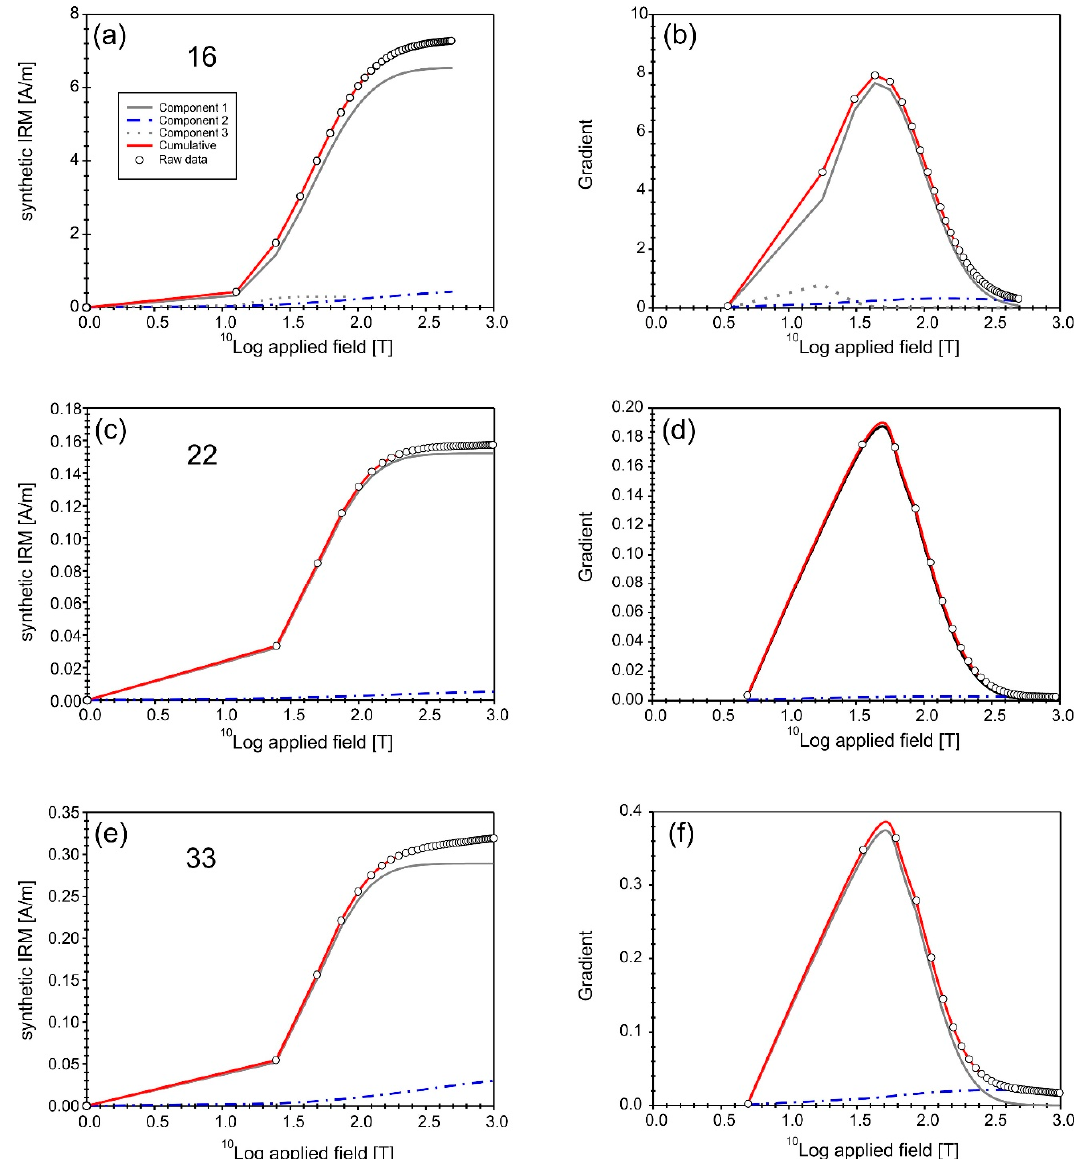
Figure 3. Isothermal remanent magnetization (IRM) decomposition plots for representative topsoil samples from the areas affected by T ř inec ( a , b ), Ostrowiec ( c , d ), and Katowice ( e , f ) ironworks. Linear acquisition plots (LAP) are shown in the left column, and gradient acquisition plots (GAP) are on the right.